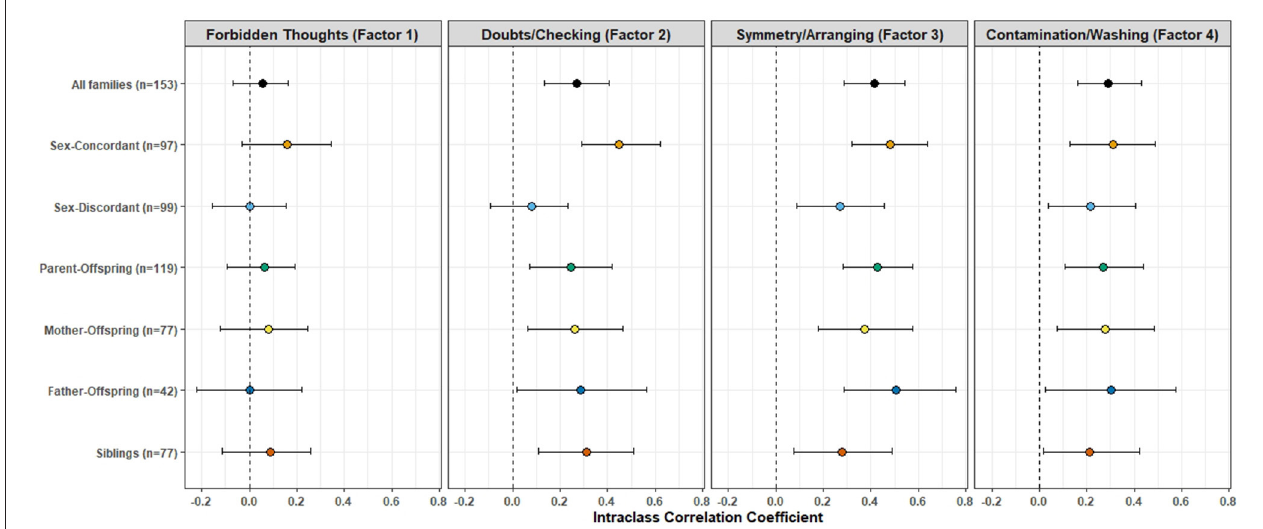
FIGURE 3 | Intra-class Correlation Coefficients (ICC) of the factor analysis-derived symptom dimension scores between first-degree relative pairs. The colored dots represent the ICC value, the error bars represent their 95% confidence intervals, for each symptom dimension and across different relationship types. See Supplementary Table 1 for the source